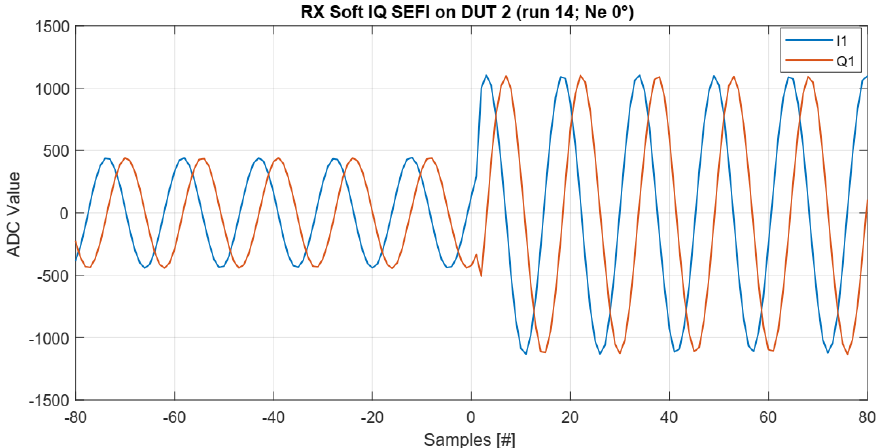
Figure 17. Hard IQ SEFI on channel 1 (I1 / Q1) of the DUT 2 receiver, showing an amplified waveform which still contains its initial frequency.